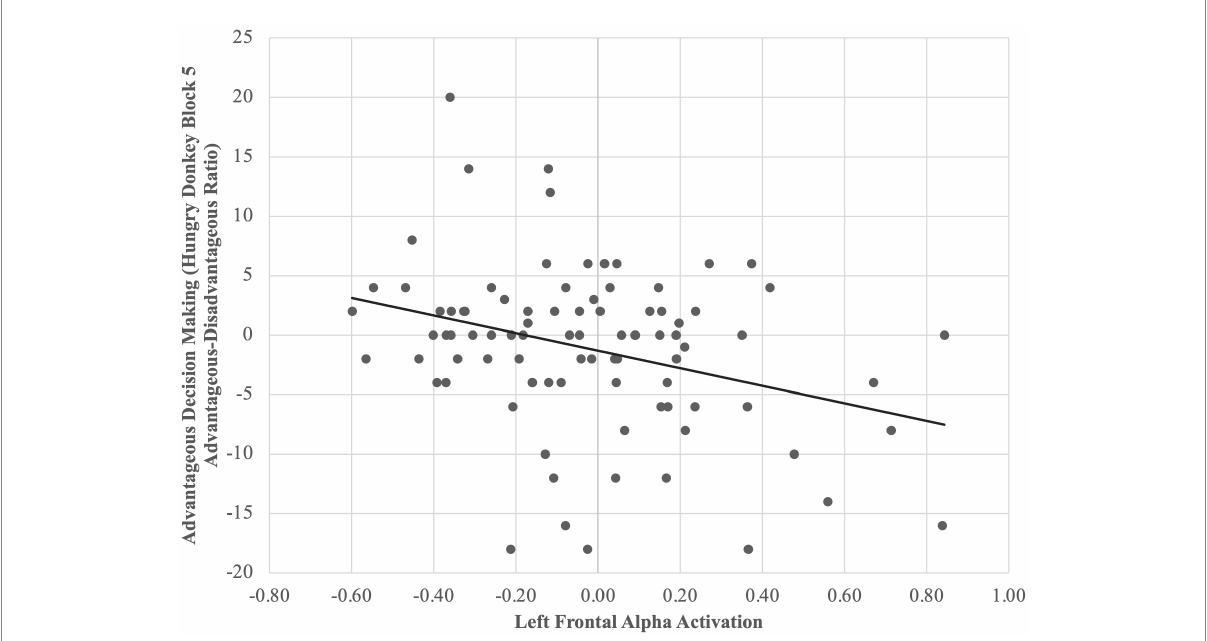
FIGURE 3 Higher relative left (vs. right) FAA predicts less advantageous decision-making across diagnostic groups. For all children, higher relative left FAA predicted worse reward contingency learning, β = 0.32, p = 0.002.